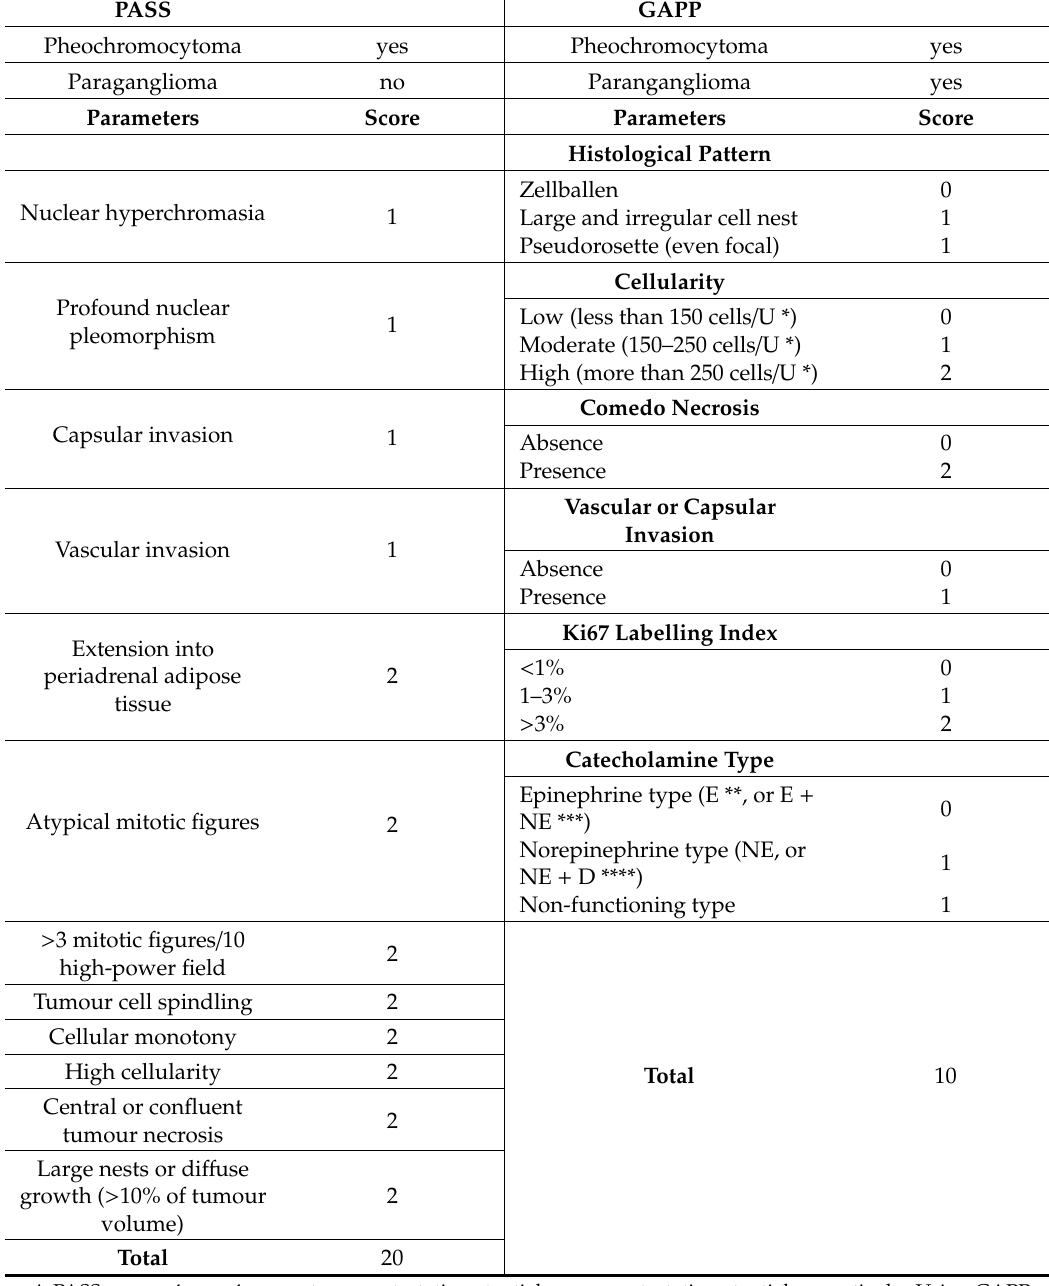
Table 2. Histopathological classification